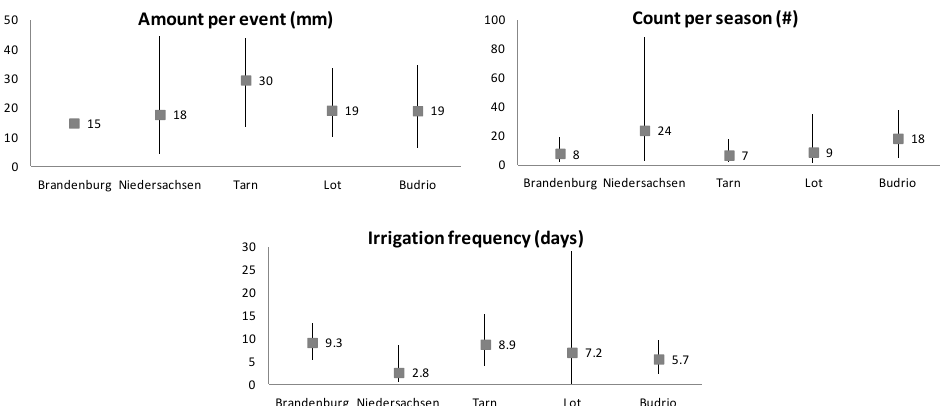
Figure 2. Statistics of irrigation events. The bars show the minimum and maximum. The square and number show the average value.